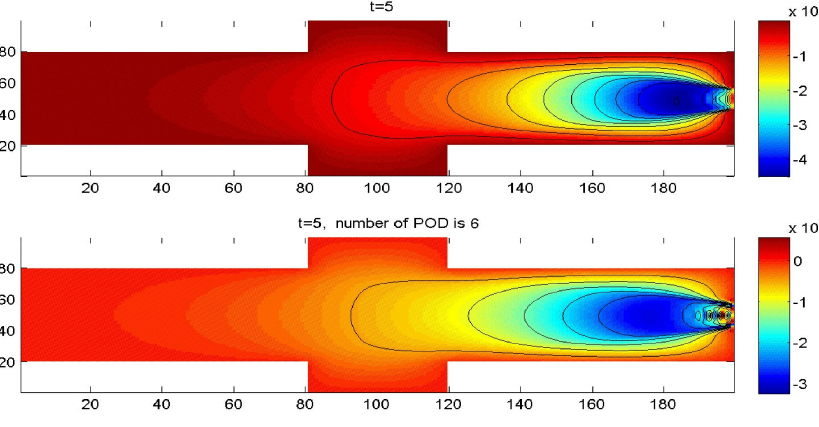
Figure 9. Top chart is the classical SCNMFE solution of pressure p and bottom chart is the POD-based reduced-order SCNMFE solution of pressure p with 6 POD bases when Re = 1000 and Pr = 7 at time t =